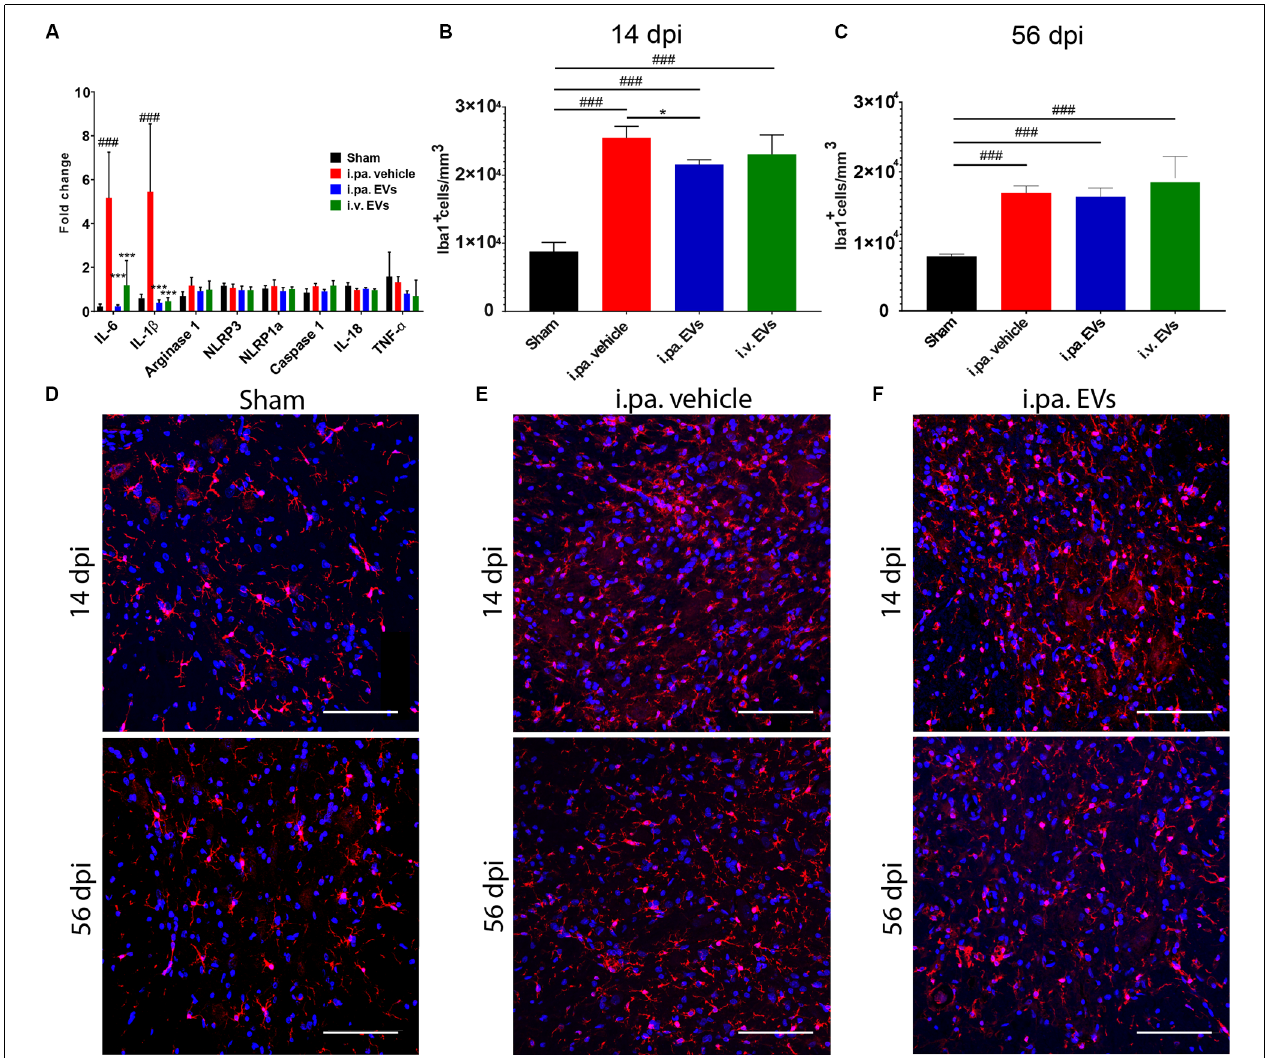
FIGURE 2 | Acute intralesional application of EVs quenched the inflammatory response after tSCI. (A) Impact of EV treatment on the expression level of pro-inflammatory genes at the lesion site after tSCI. The density of Iba1-expressing cells was quantified at 14 days (B) and 56 days (C) after tSCI in the ventral horn. Representative immunodetection of Iba1 in the spinal cord of rats from (D) the sham group, (E) from the i.pa. vehicle-treated tSCI group and (F) from the i.pa. EVs- treated SCI-group (2 mm rostral from the epicenter). Immunodetection of Iba1-expressing microglia (red) was performed 14 days and 56 days post-tSCI. Nuclear counterstain was obtained with DAPI (blue). Scale bar = 50 µ m. Statistical differences to sham group using one-way ANOVA and Tukey post hoc test: ( ### ) p < 0.001, statistical differences to i.pa. vehicle group using one-way ANOVA and Tukey post hoc test on tSCI groups (without sham): ( ∗ ) p < 0.05, ( ∗∗∗ ) p < 0.001. Days post-injury: